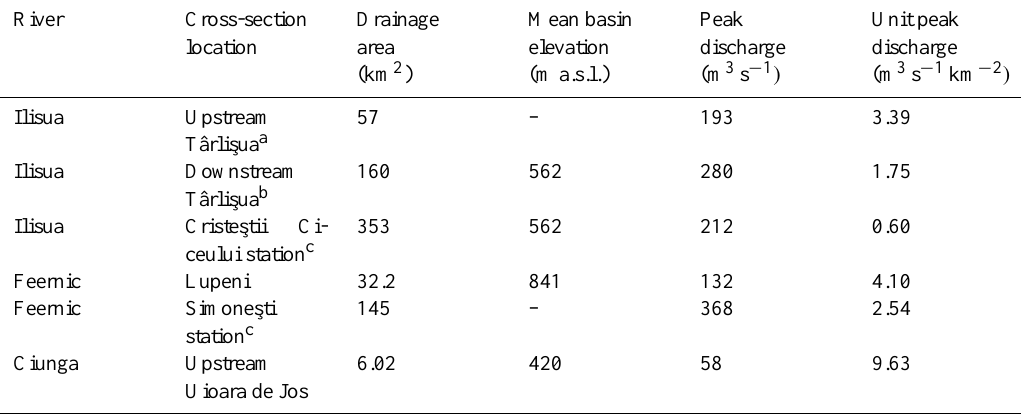
Table 3. The flash-flood peak disharges and unit peak discharges in the analyzed cross sections. River